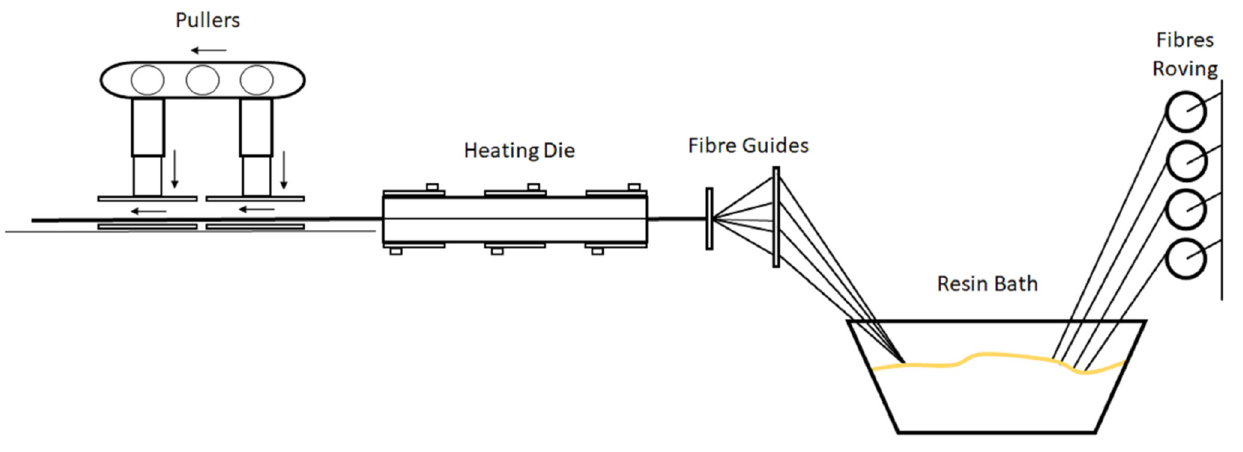
Figure 1. FRP pultrusion process used.